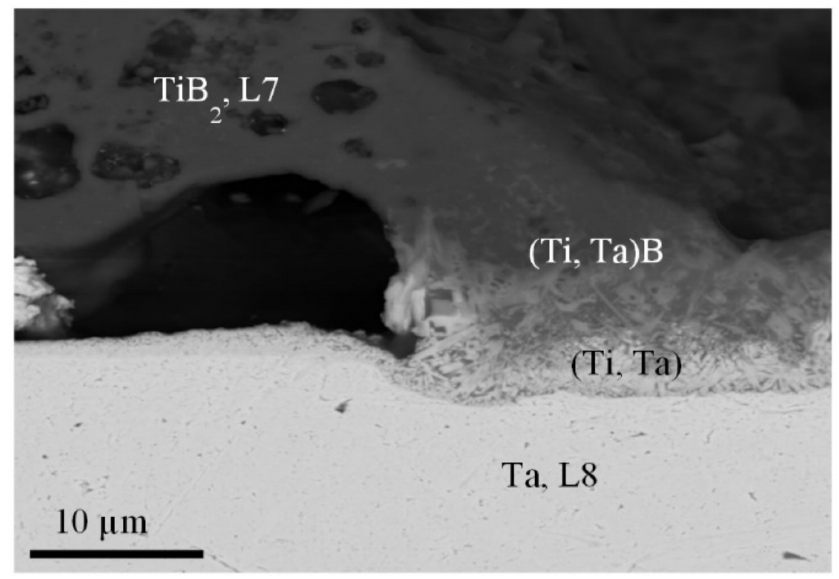
Figure 14. Microstructure of Ta–TiB 2 joint at L7–L8 interface in cross section of burned Set 3